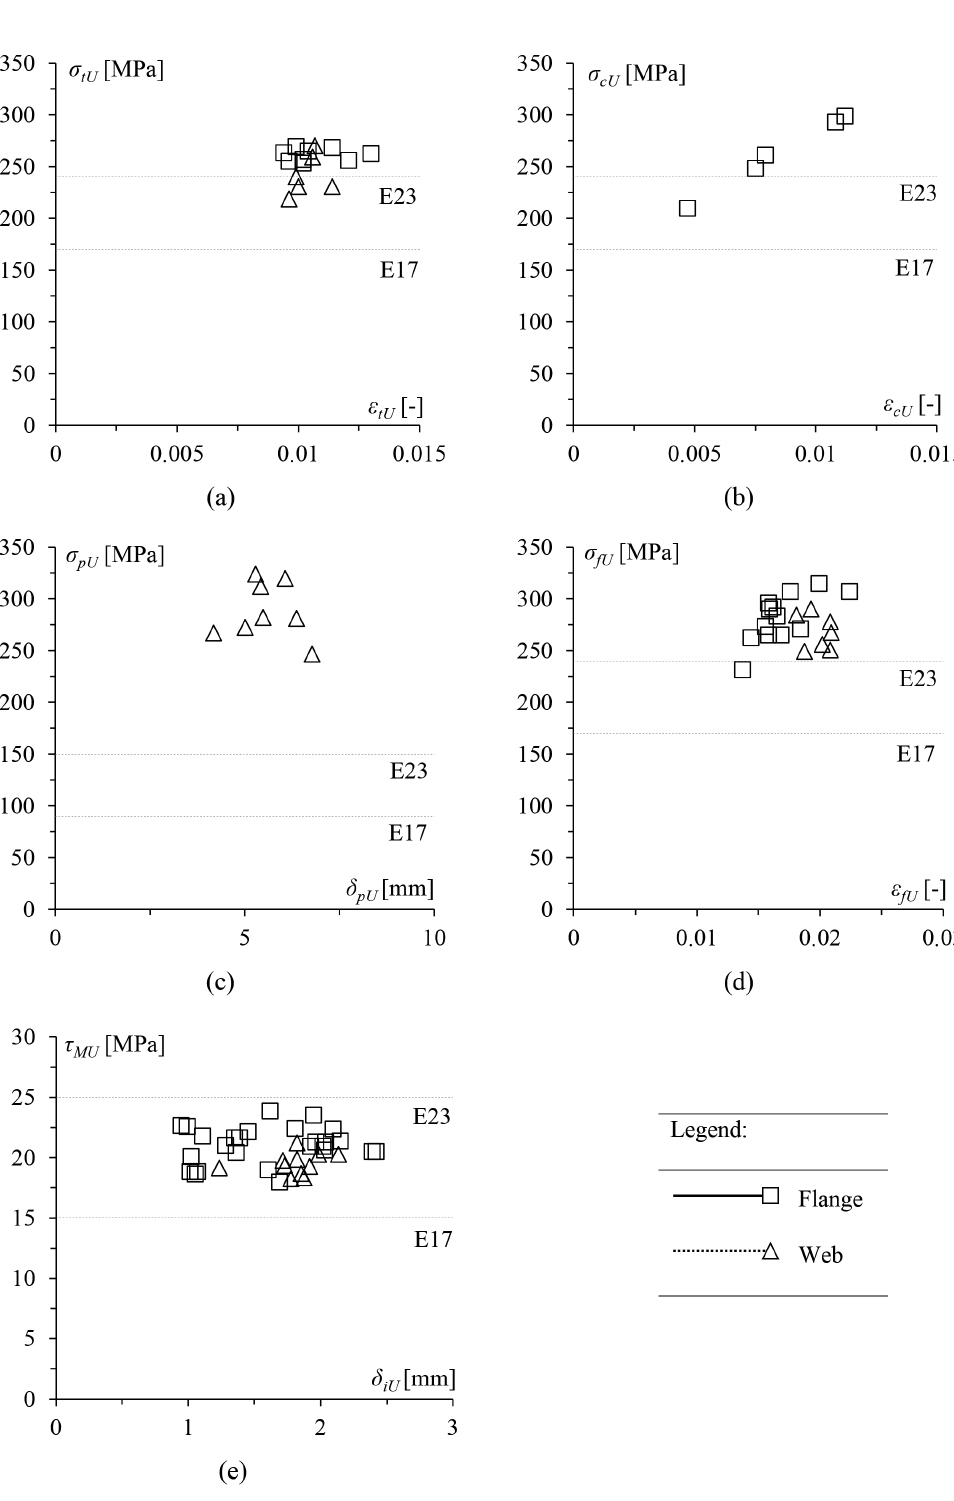
Figure 6a-e plot the obtained ultimate strength against the associated strain, concerning the (i) direct tension and